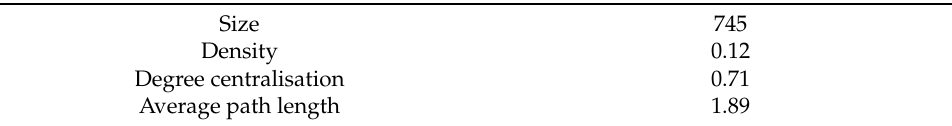
Table 4. Indexes of the collaboration networks.